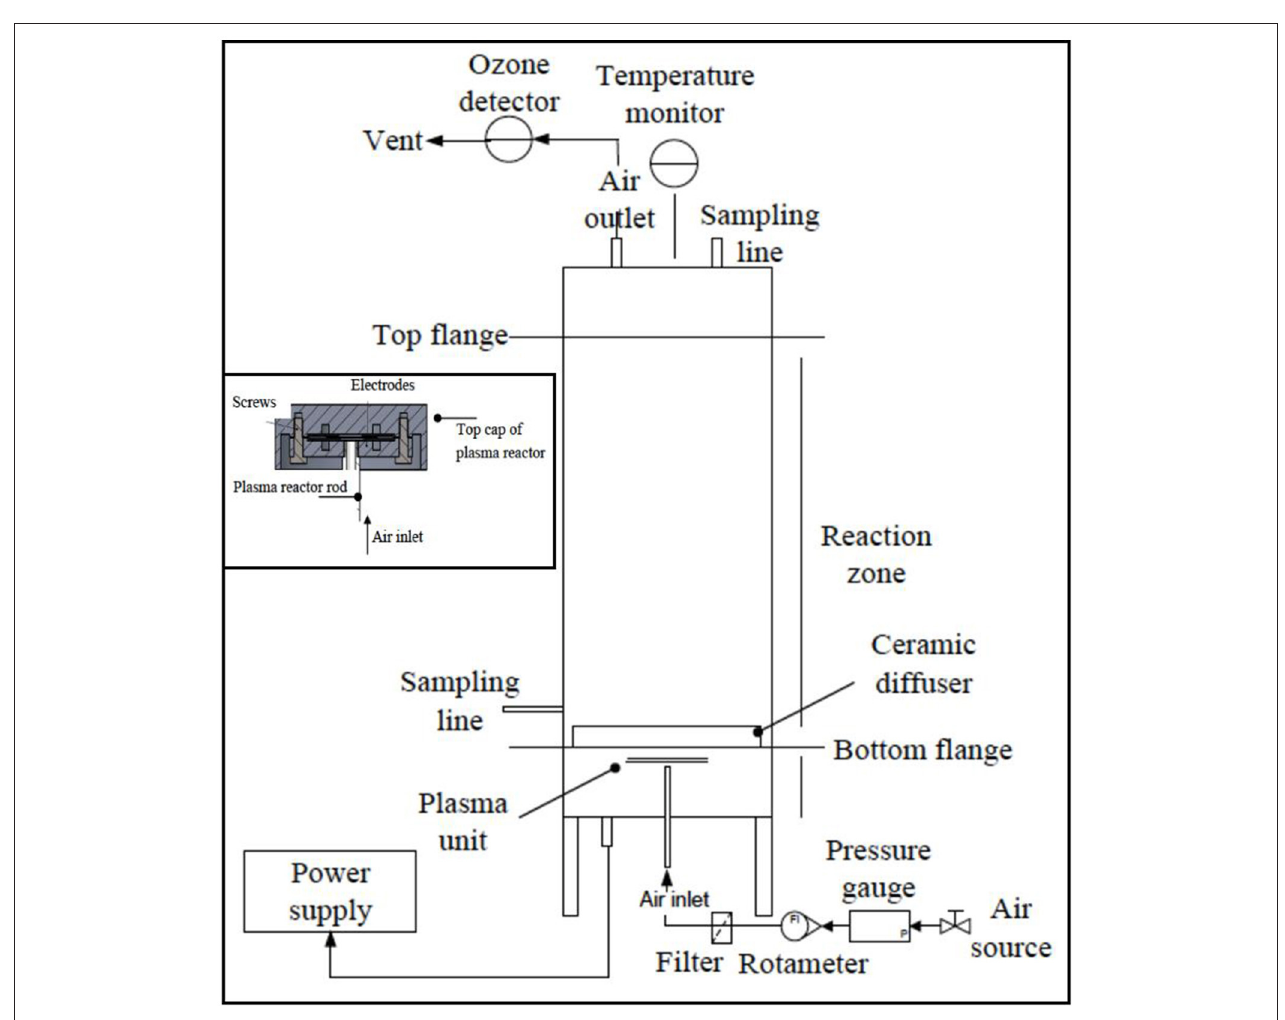
FIGURE 1 | The experimental plasma microreactor. The suggested working voltage level was 4 kV with the plasma unit connected to a 500 W/50 kHz/4 kV plasma power supply (Dipl.Ing.H.Bayerle, Germany) Inset: A diagram of the experimental reactor performing